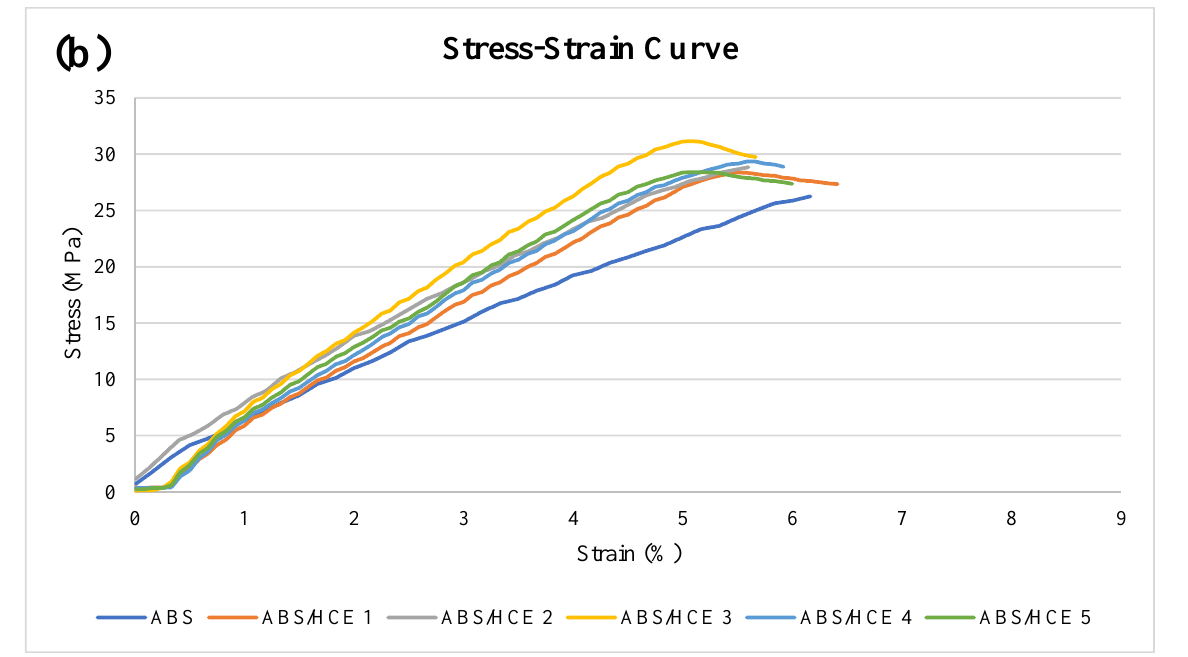
Figure 11. Comparative tensile test results for ABS/HCE composites: ( a ) results from tensile testing with standard deviation as error bars; ( b ) stress-strain curve.